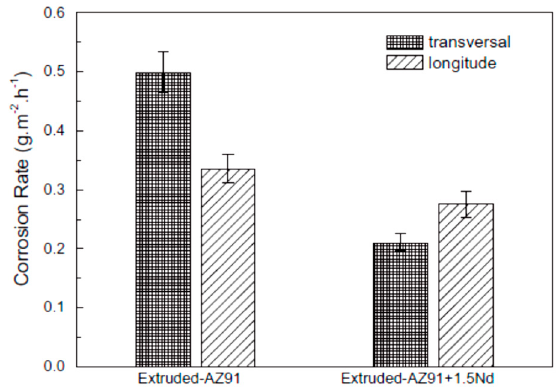
Figure 30. Corrosion rate of AZ91 with and without Nd. Reproduced with permission from [159], Elsevier, 2011.